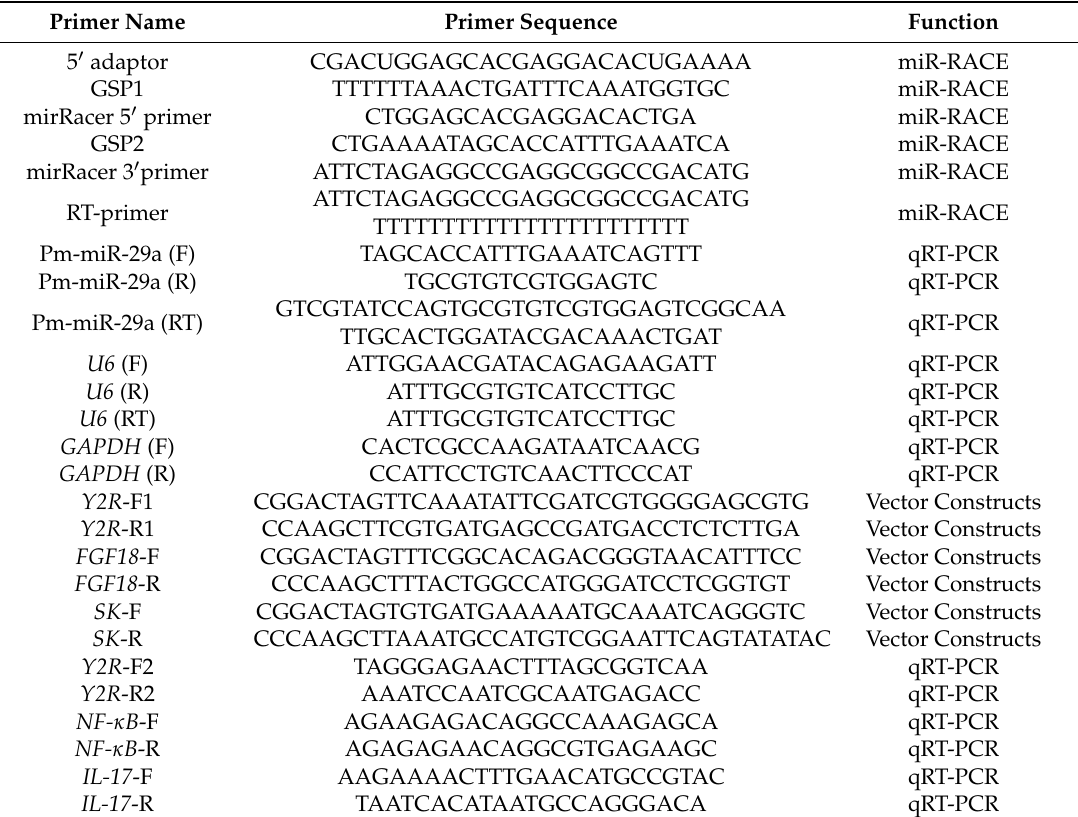
Table 1. Primer sequences used in this